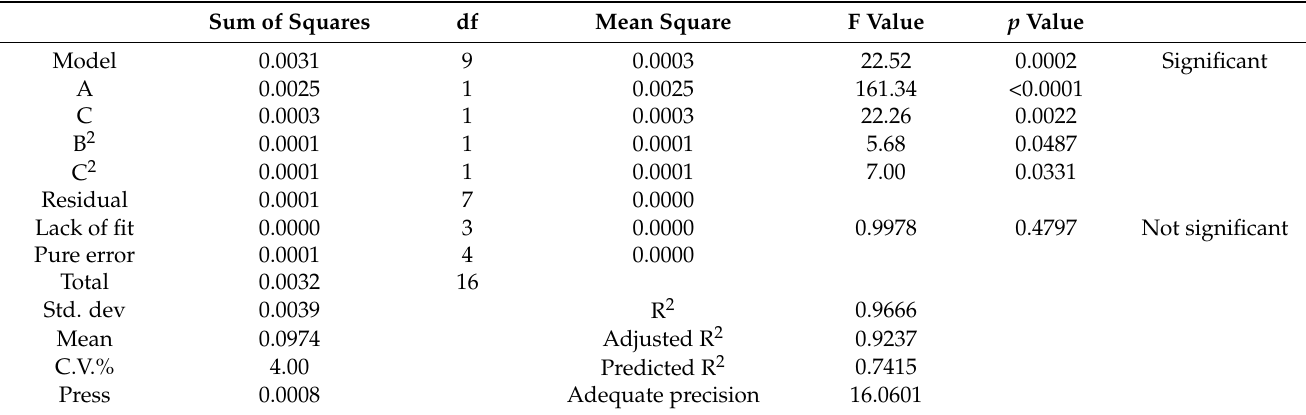
Table 5. Analysis of variance of the dilution